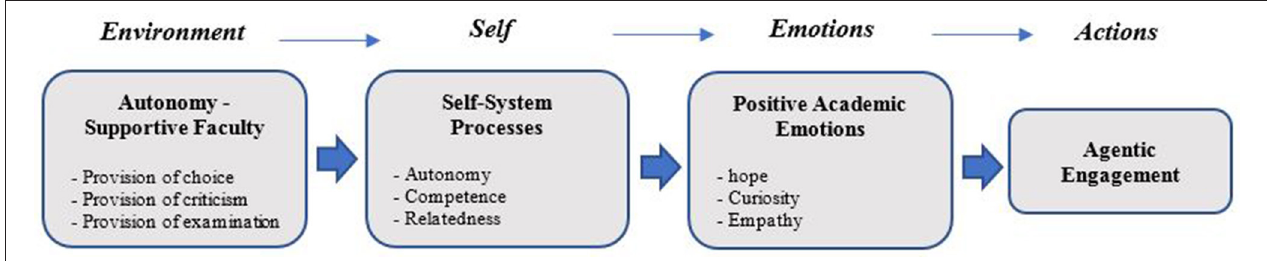
FIGURE 1 | The conceptual model of current study extends Self-System Model of Motivational Development (Connell and Wellborn, 1991) together with consideration of Control-Value Theory (Pekrun and Linnenbrink-Garcia, 2012).